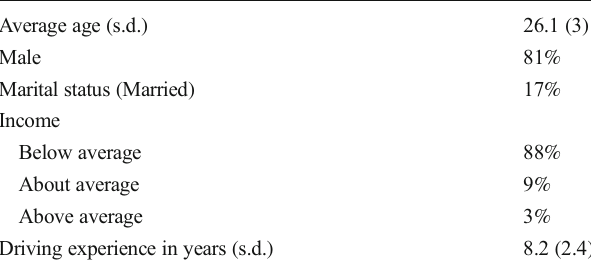
Socio-demographic characteristics of the participants Average age